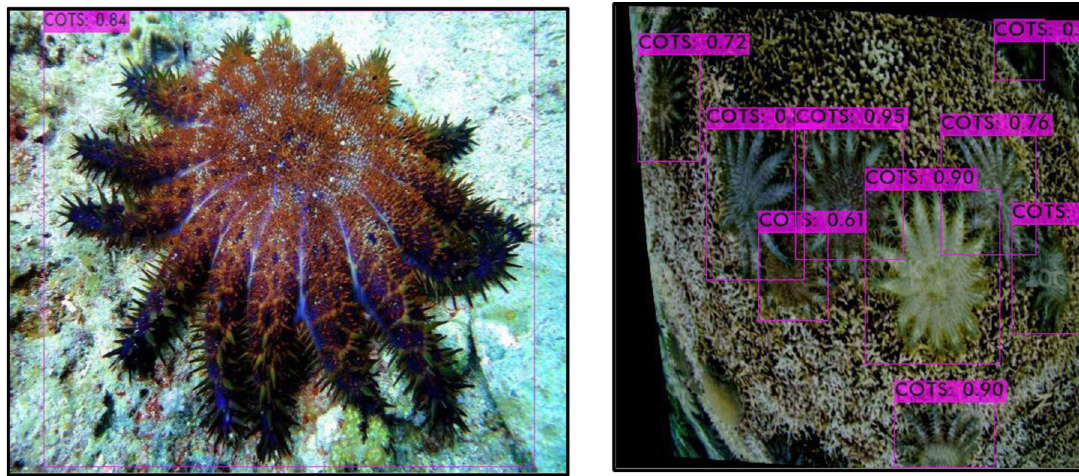
Fig 8. Correct Detection of starfish using